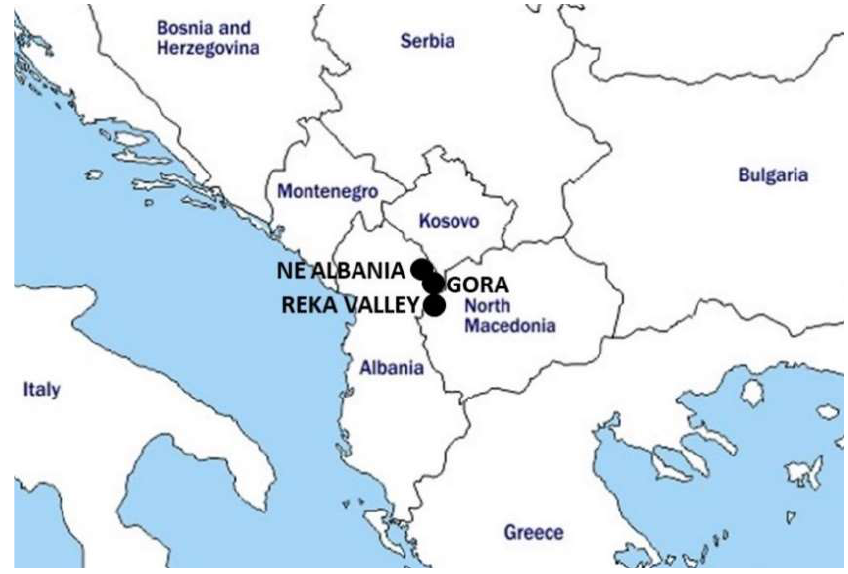
Figure 6. Map of the compared areas (NE Albania—inhabited by Albanians; Reka valley, North Macedonia—inhibited by Reka Albanians; Gora, Albania and Kosovo—inhabited by the Gorani people) [17–20,30,31].